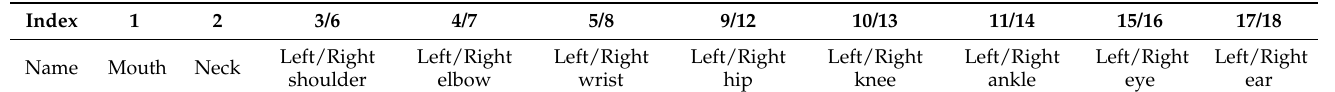
Figure 2. Pedestrian key points. Table 1. Index of pedestrian key points.